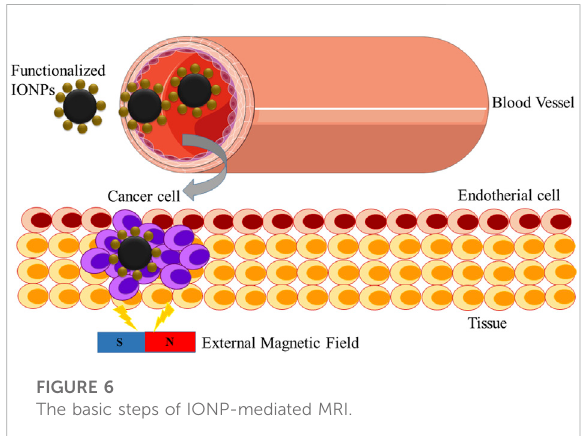
FIGURE 6 The basic steps of IONP-mediated